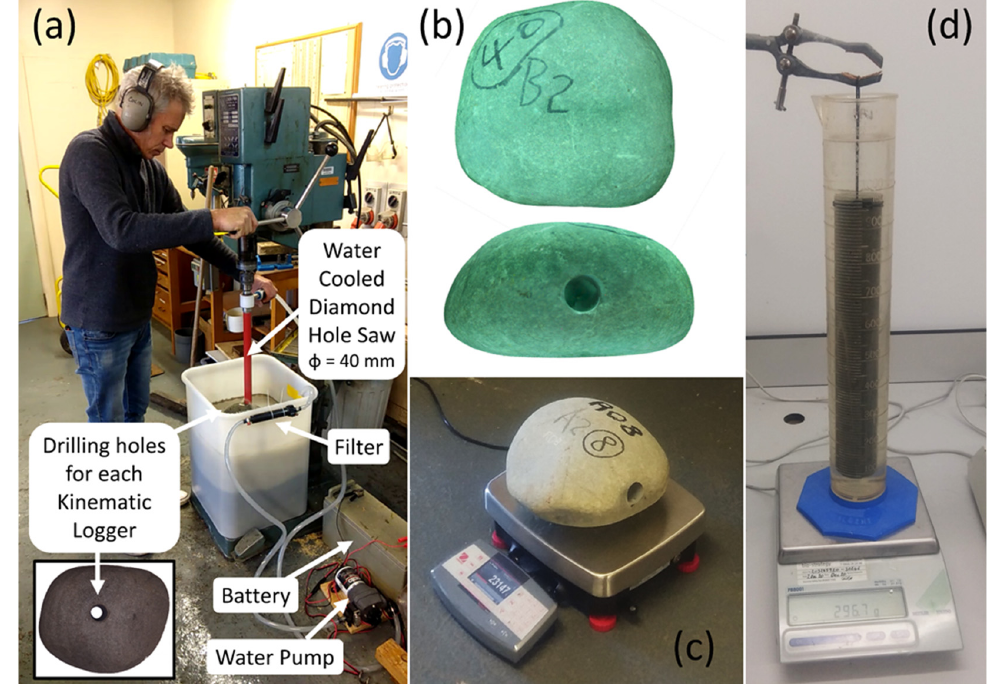
Figure 3. ( a ) NIWA technician Julian Sykes drilling holes through greywacke stones for installation of Kinematic Loggers, ( b ) 3D scans of the greywacke stones, ( c ) weighing stones before installation of Kinematic Loggers and field deployment, ( d ) measurement of volume of greywacke cores using Archimedes’ principle for calculations of greywacke density.